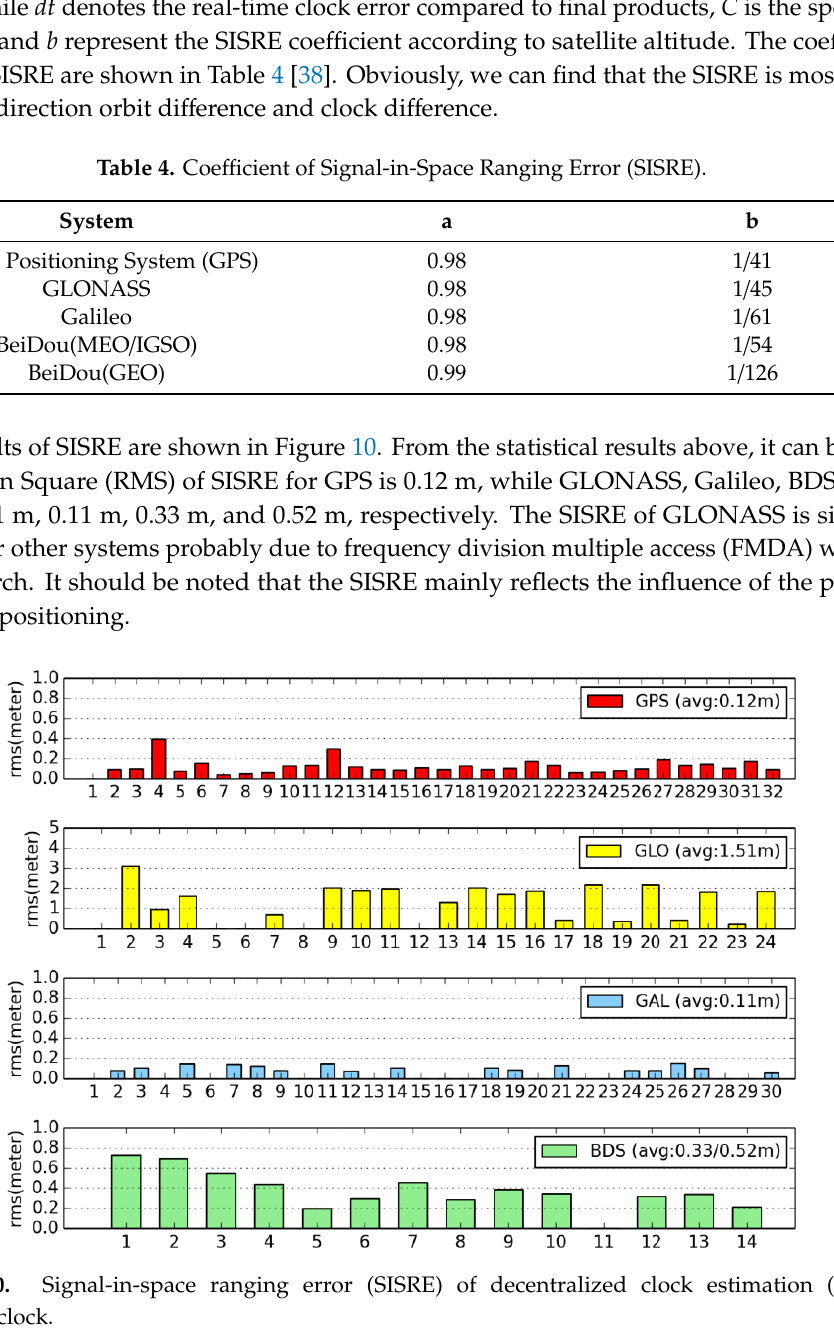
Figure 10. Signal-in-space ranging error (SISRE) of decentralized clock estimation (DECE) real-time